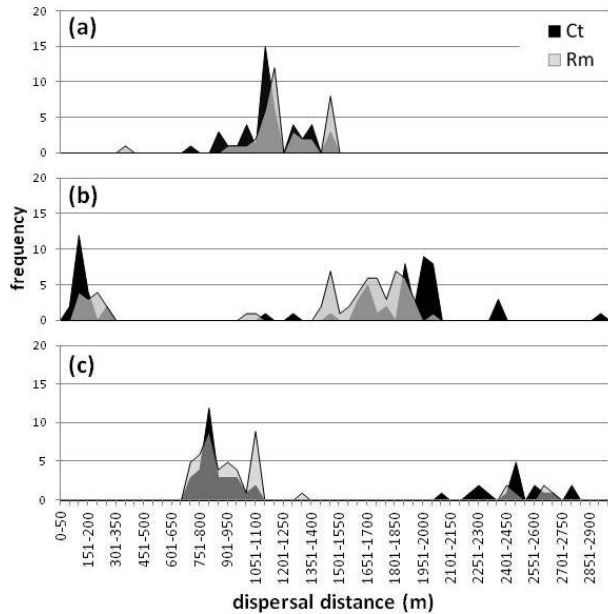
Fig. 6. Dispersal distance distribution (number of propagules) for Ceriops tagal (black) and Rhizophora mucronata (grey) propagules used in the release-recapture experiment in the field, for propagules dropped at location L1 (a) ; at location L2 (b) ; and at location L3 (c) . Locations are indicated in Fig.